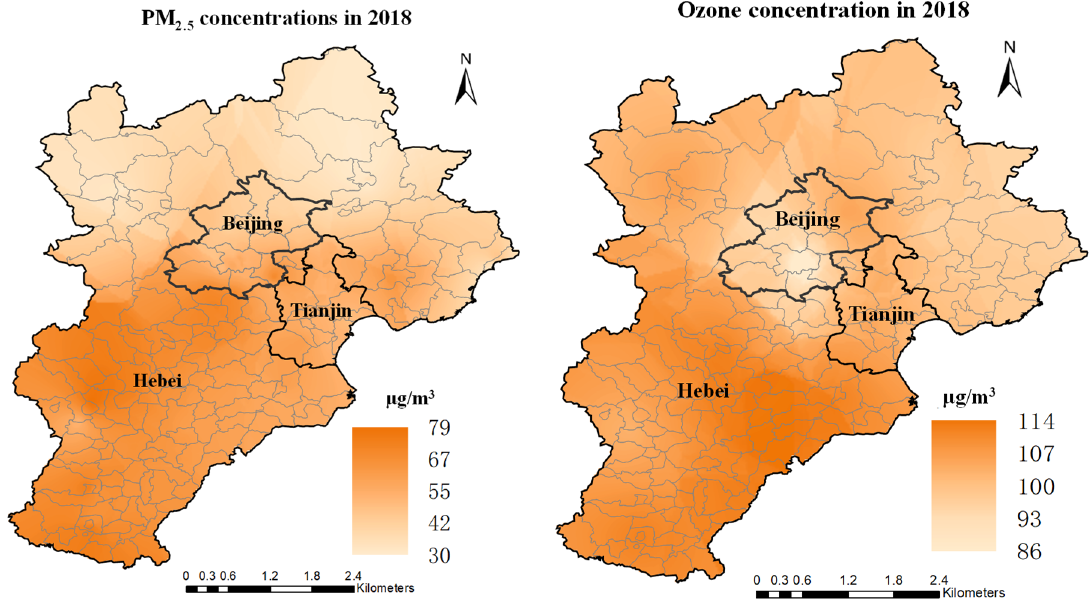
Figure 3. Spatial distribution of annual concentrations of PM 2.5 ( left ) and average top consecutive 8 h concentration of ozone ( right ) in the Beijing–Tianjin–Hebei region in 2018.